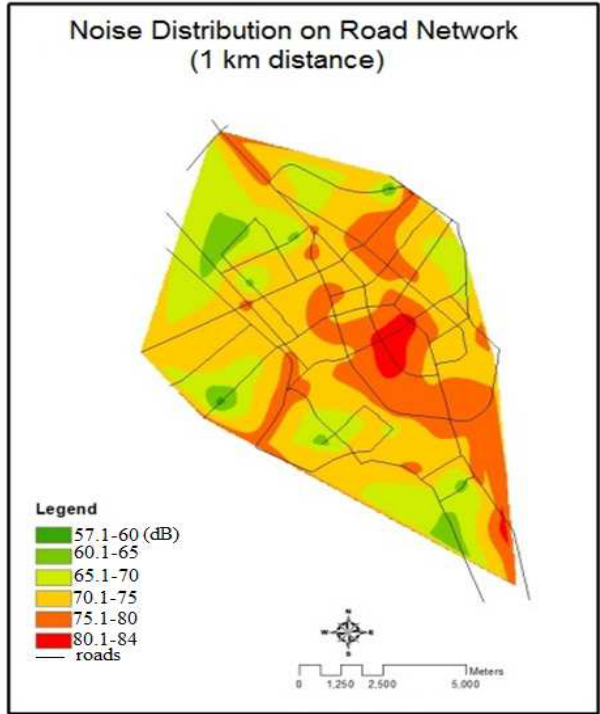
Figure 2. Yazd city noise map of road network